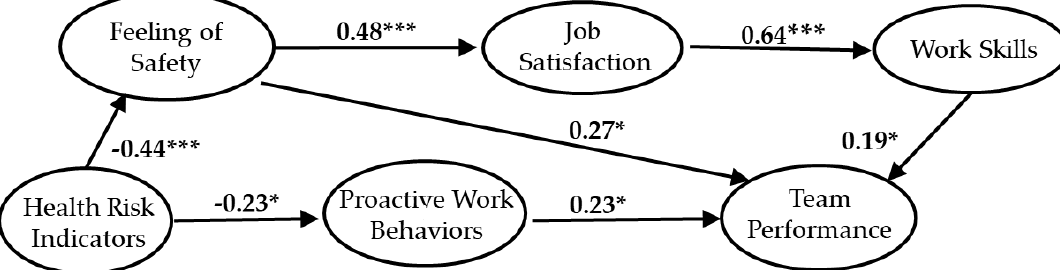
Figure 4. Standardized parameter estimates for the final structural model of older workers. * indicates p < 0.05; *** indicates p < 0.001. The path coefficient is a standardized estimate value.